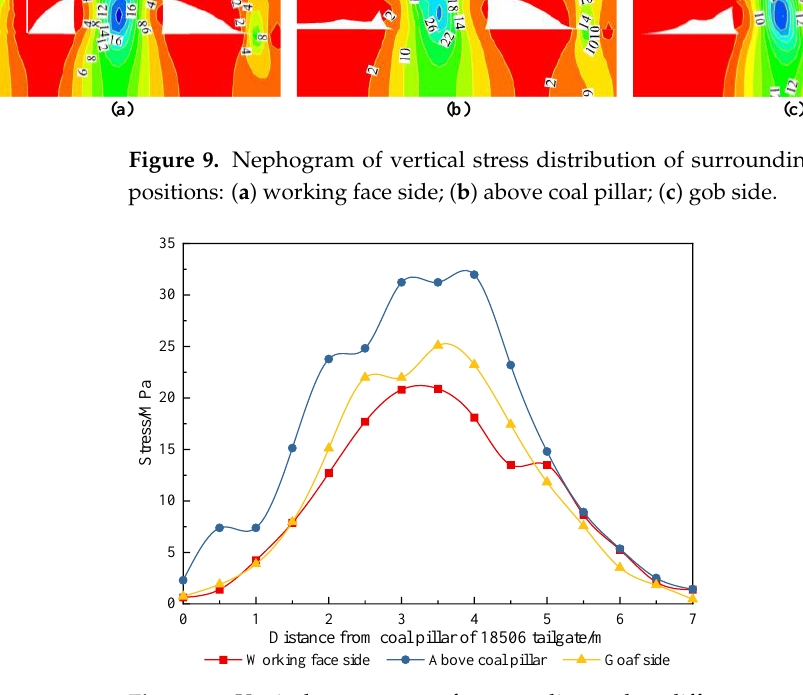
Figure 10. Vertical stress curve of surrounding rock at different top cutting positions.